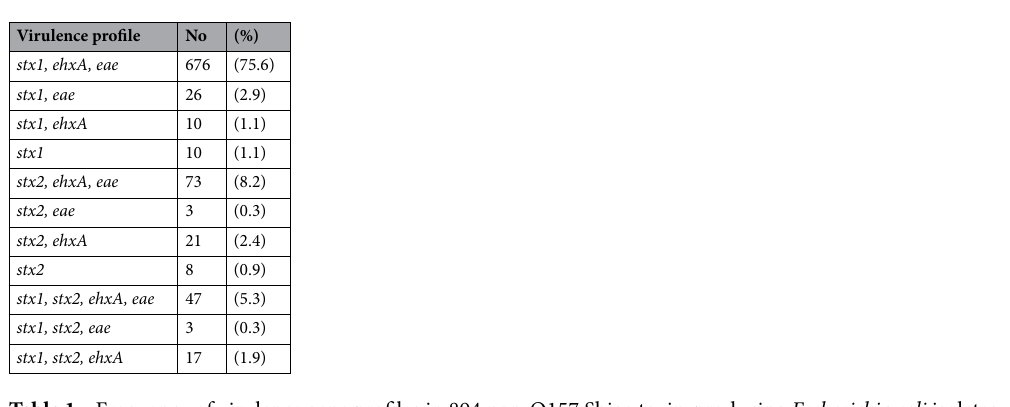
Table 1. Frequency of virulence gene profiles in 894 non-O157 Shiga toxin-producing Escherichia coli isolates from Michigan patients,